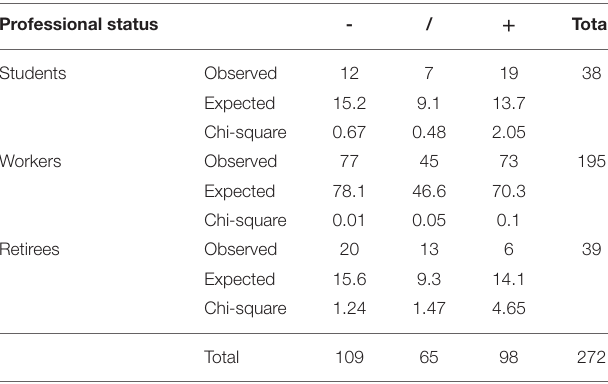
TABLE 6 | Frequencies of experience of lockdown by professional